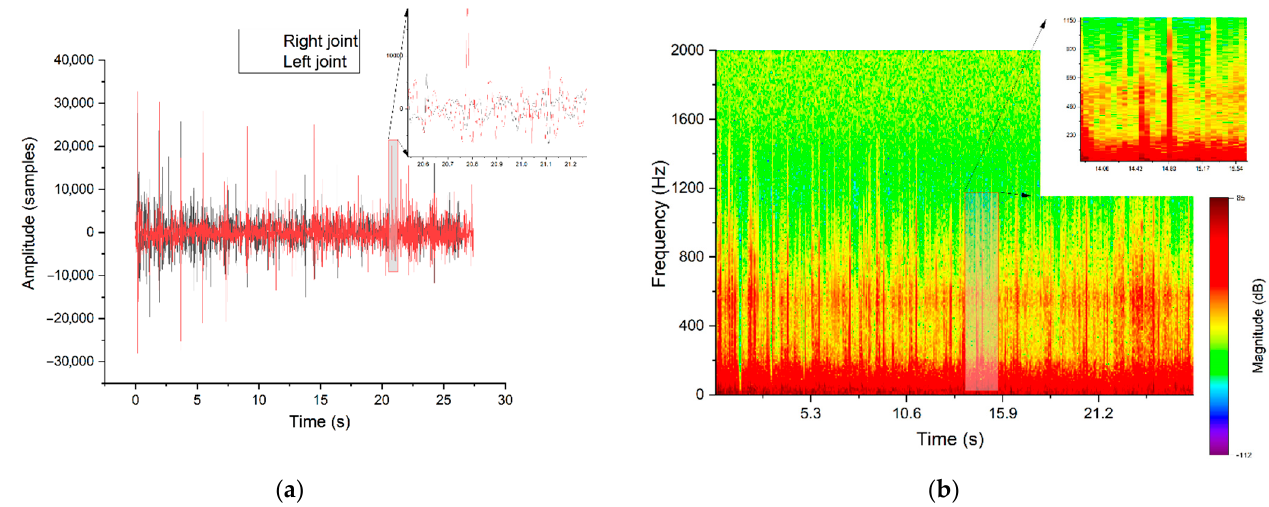
Figure 3. Signal traces recorded on both sides in the time domain ( a ) and the short–time Fourier transform (STFT) representation of a healthy TMJ ( b )—representative parts of one jaw movement were magnified.